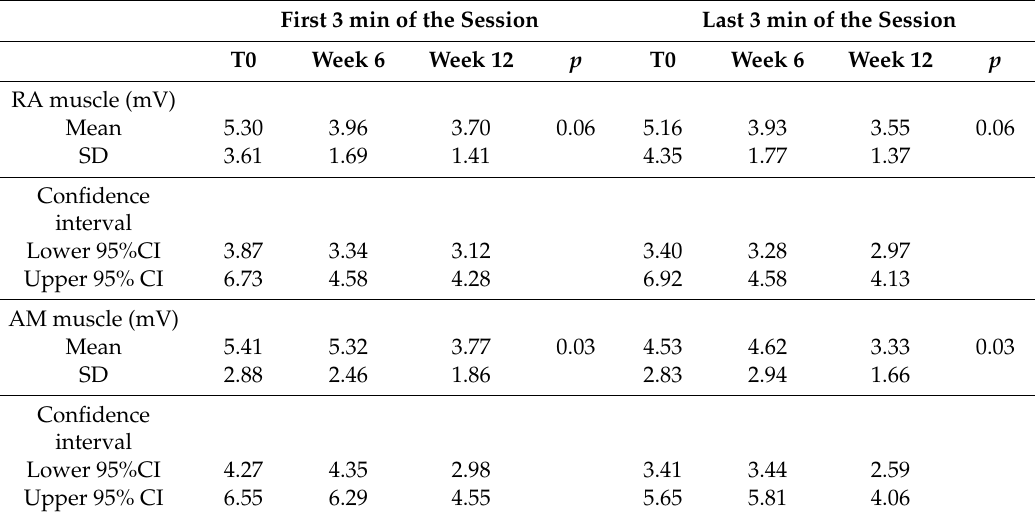
Table 6. Comparison of the mRMS values (in mV) for the RA and AM muscles with respect to the time of treatment (initial value at T0, intermediate value at week 6, and final value at week 12). p -values correspond to the ANOVA statistics.